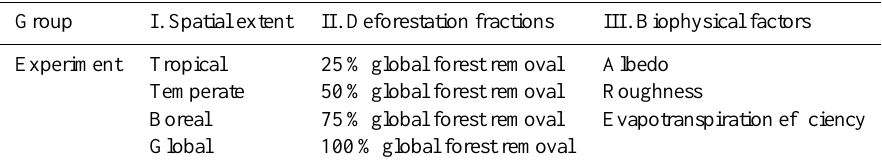
Table 1. Deforestation experiment